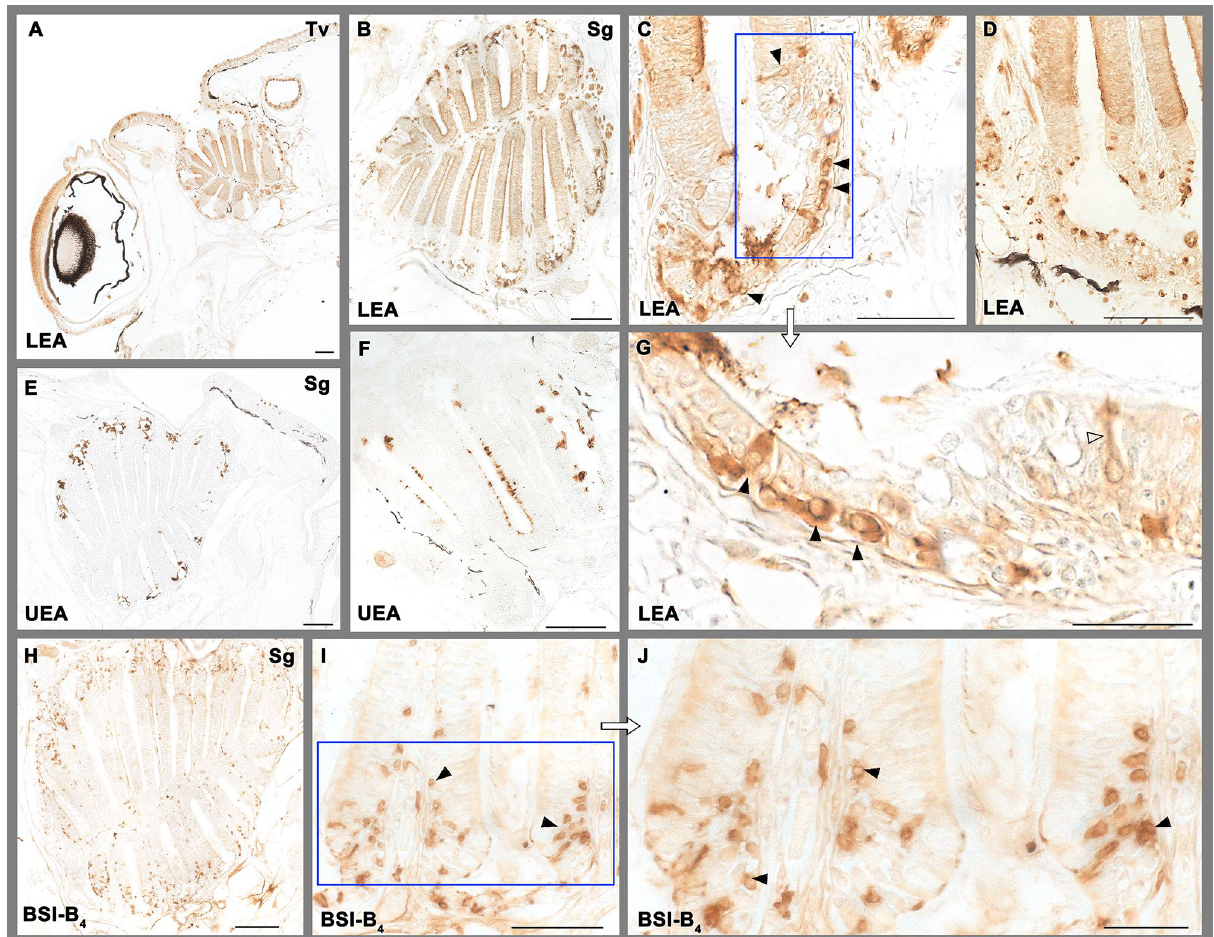
Figure 5. Lectin histochemical staining of the olfactory rosette. ( A – D , G ) LEA marks intensely the olfactory epithelium dividing it clearly from the unstained nonsensory epithelium in both transverse ( A ) and sagittal ( B ) sections. In the nonsensory epithelium ( C , D , G ) it labels big oval neuron-like somas (black arrowheads) in the crypts. Thin dendritic processes can be clearly appreciated (white arrowhead in G ). ( E , F ) UEA labels secretory material, mainly in the crypts, but also in the sensory epithelium. ( H – J ) BSI-B 4 labels neuron-like cells in the nonsensory epithelium (arrowheads), including its crypts. Scale bars: 100 µm ( A , B , D , E , H ); 50 µm ( C , F , I ); 25 µm ( G , J